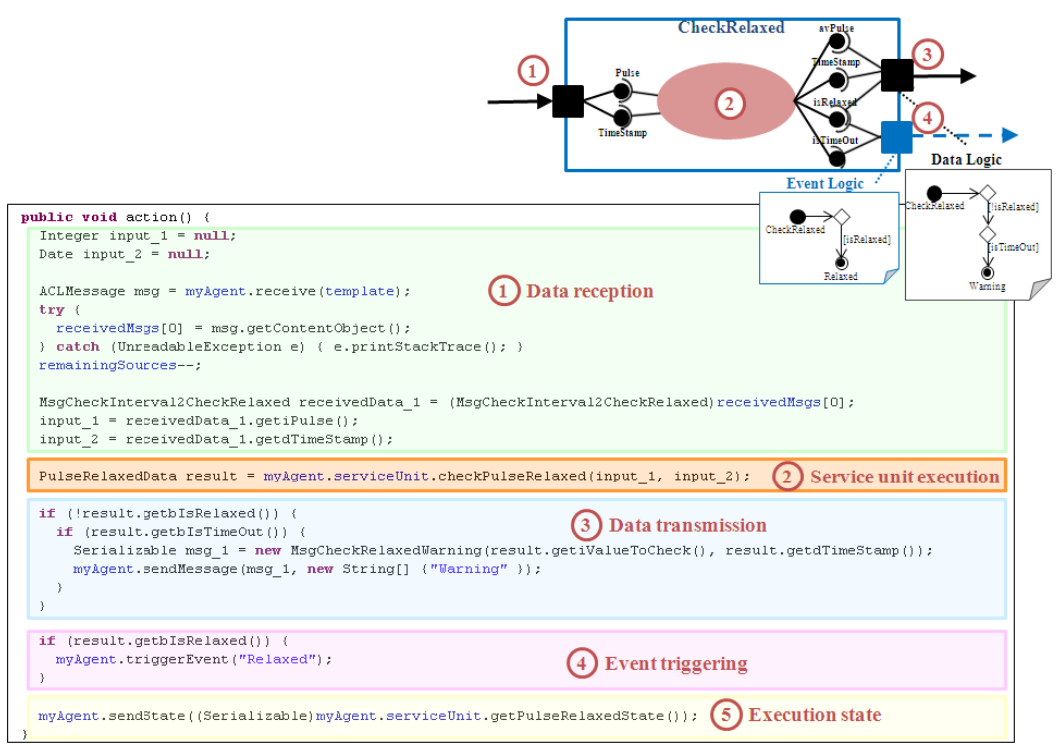
Figure 8. Customization process of the Running FSM state for the CheckRelaxed component.